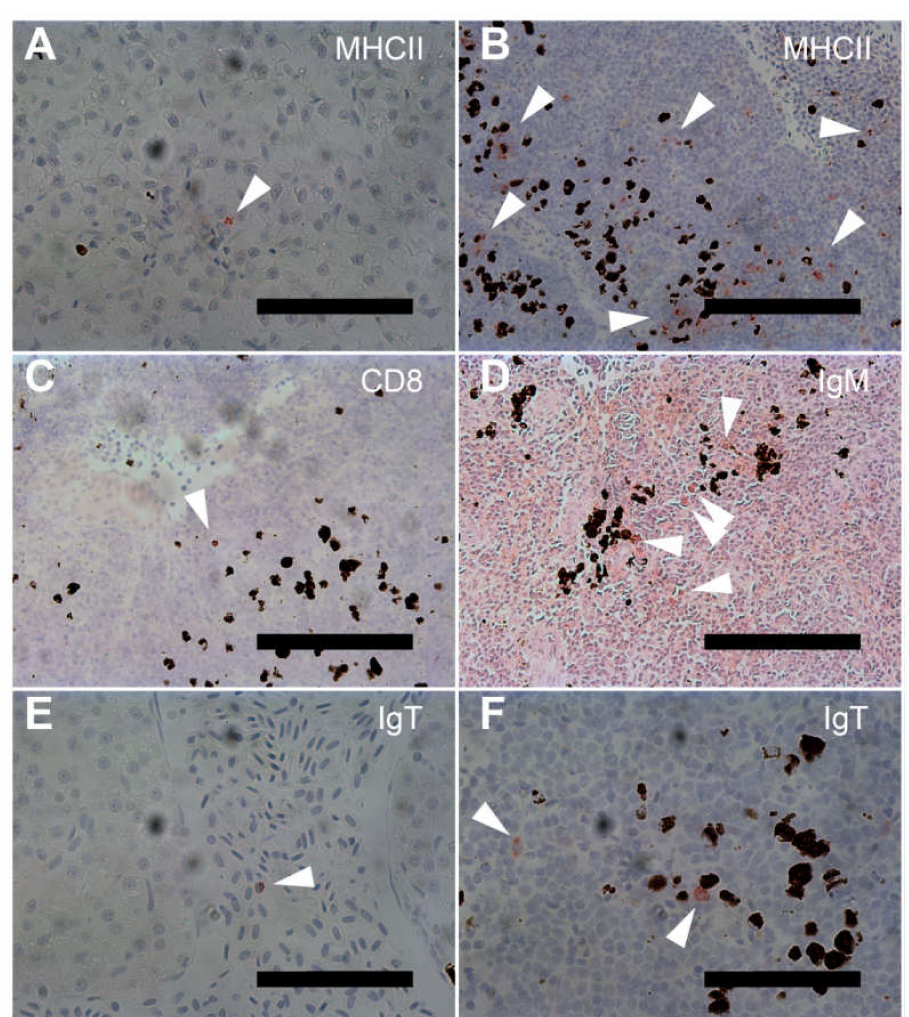
Figure 2. Immunohistochemical staining of tissue sections. Staining was performed as described in the Materials and Methods section. Arrowheads are placed to aid identification of immunopositive